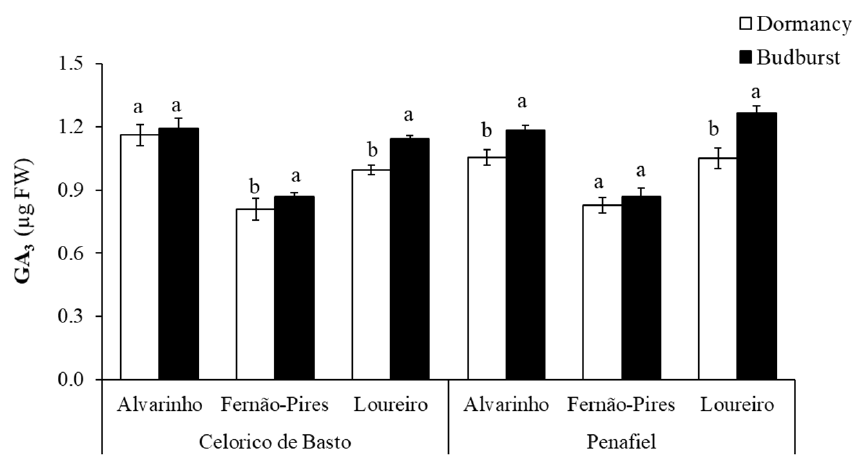
Figure 5. Gibberellic acid (GA 3 ) content at dormancy and budburst for Alvarinho, Fernão-Pires and Loureiro buds from Celorico de Basto and Penafiel sites. The columns represent the mean values and the bars the respective standard error of three replicates. Different letters indicate significant differences between phenological stages ( p < 0.05).